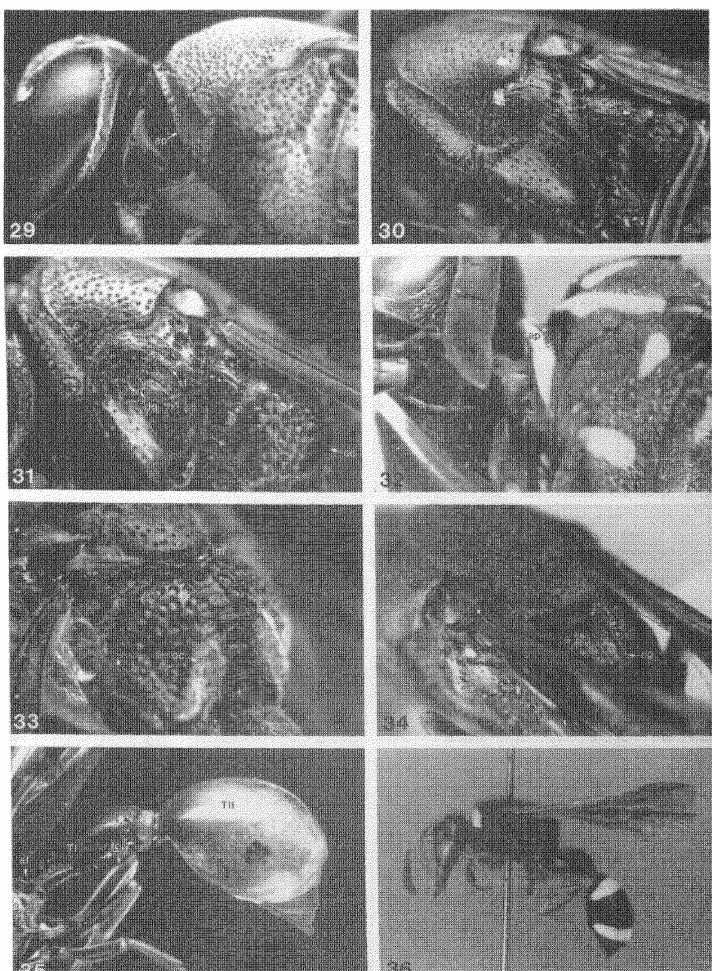
Figs. 29-36. 29-32. Lateral view of pronotum and mesepisternum. 29. Para- masaris richardsi, 13X. 30. P. brasiliensis, 14X. 31. P. fuscipennis, 17X. 32. Parischnogaster mellyi, 16. 33-34. Oblique lateral view of propodeum. , 33. P. fuscipennis, 17X. 34. P. cupreus, 15X. 35. P. brasiliensis holotype, 9X. 3. Lateral view. ap: anterior Lateral view of metasoma. 36. Gayella reedi pronotal carina; at: anterior truncation of metasomal tergum I; cg: carina